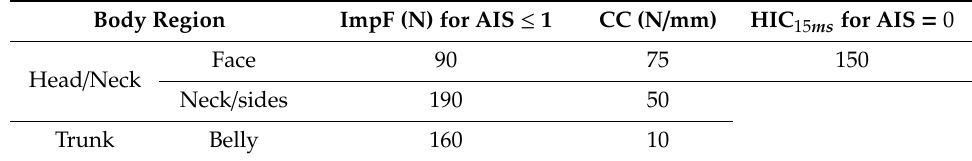
Table 3. Safety criteria thresholds for most critical body regions from ISO / TS15066 and Payne [31]. ImpF = impact force; AIS = abbreviated injury scale; CC = compression criterion; HIC = head injury